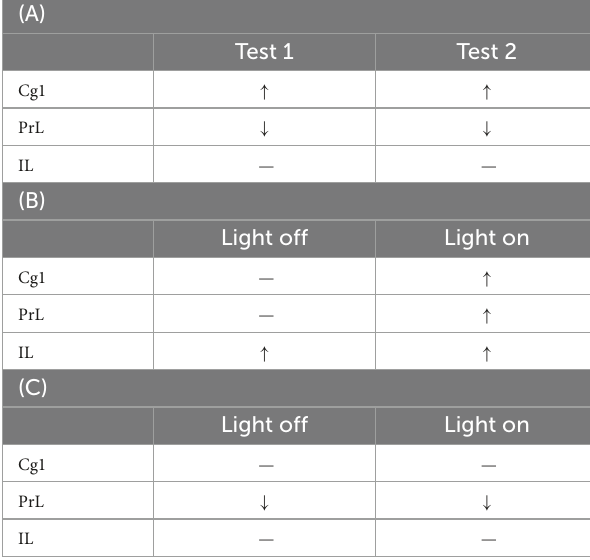
(A)AssesstherewardingvalenceofthesaccharinsolutionconsumptioninTest1andTest2. (B)Assessaversivesaccharinsolutionsuppressioninducedbymorphineintheconditioning phase. (C) Assess aversive saccharin solution suppression induced by morphine in the extinction phase. —, non-significant differences; ↓ , decrease; ↑ , increase; Cg1, cingulate